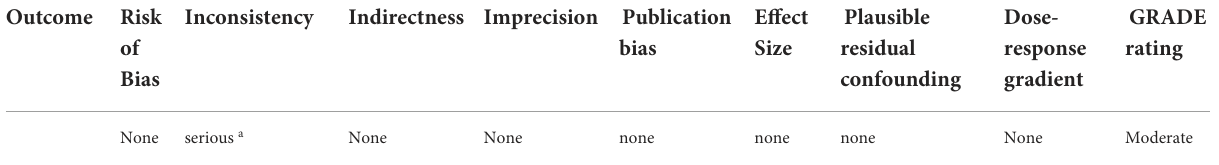
TABLE 4 Grades of Recommendation, Assessment, Development and Evaluation (GRADE) quality of